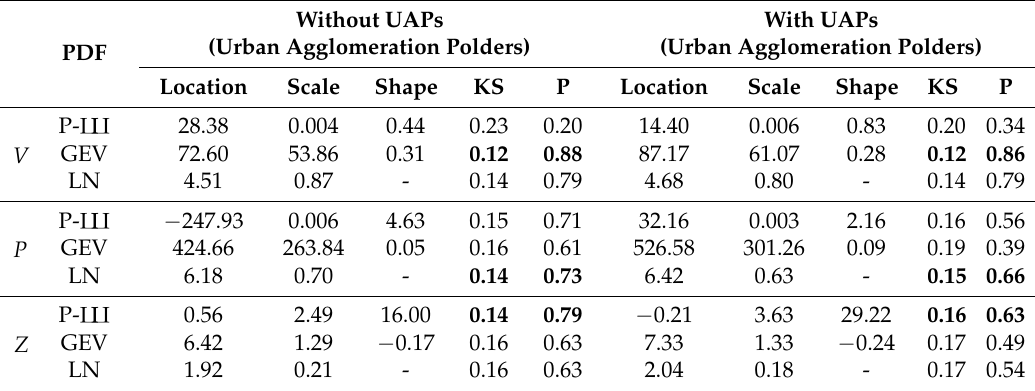
Table 2. Parameter estimation and fitting performance of marginal